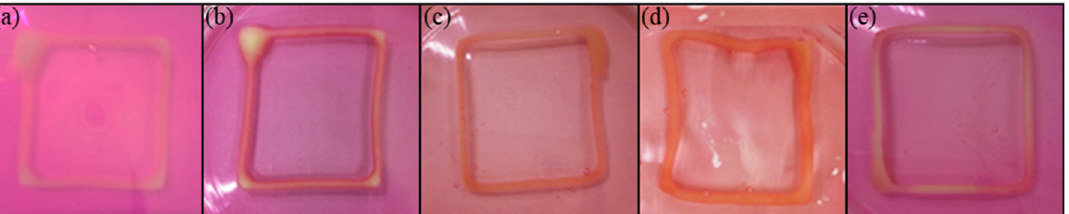
Figure 5. The polymerized structures of ( a ) AGLC01, ( b ) AGLC05, ( c ) AGLC10, ( d ) AGLC20, and ( e ) AGLC40.